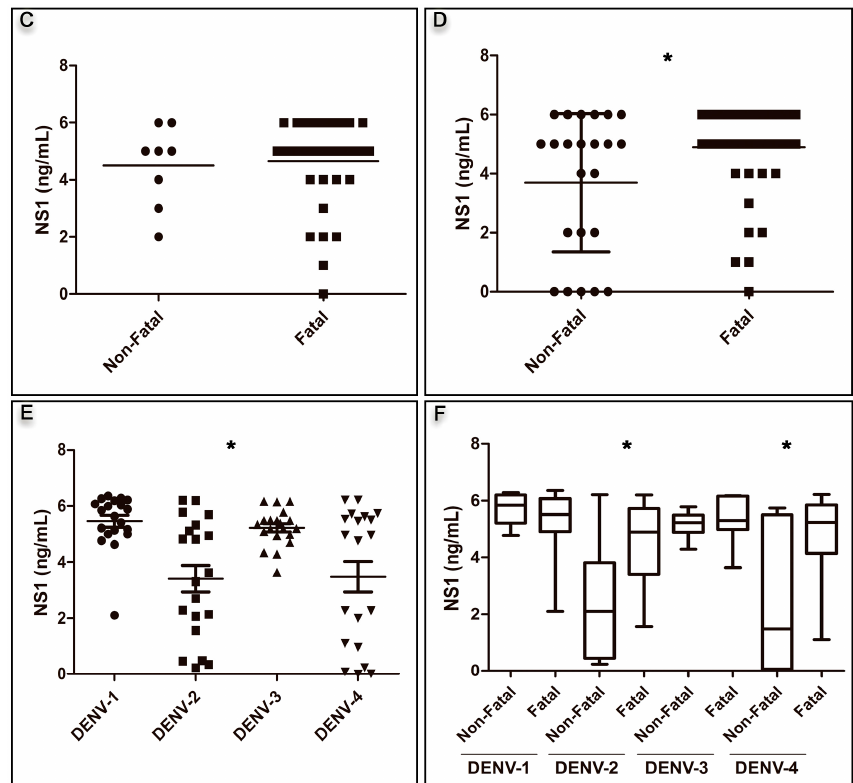
Figure 1. Non-structural protein 1 (NS1) antigenemia ( A ) according to the disease outcome (non-fatal: n = 40; fatal: n = 40), * p < 0.01 using t test; ( B ) in the overall analysis of the type of infection (primary: n = 24 versus secondary: n = 45) using t test; ( C ) in the analysis of primary non-fatal ( n = 8) versus fatal ( n = 16) cases by t test; ( D ) in the secondary non-fatal ( n = 23) and fatal ( n = 22) cases, * p < 0.01 using t test; ( E ) in the analysis of DENV serotype regardless of the disease outcome ( n = 80) by ANOVA test * p < 0.01; ( F ) in the analysis of the distinct DENV serotypes according to the disease outcome (fatal: n = 10 and non-fatal/serotype) using t test. For DENV-2, fatal versus non-fatal cases, * p < 0.01, and for DENV-4 fatal versus non-fatal cases, * p < 0.01.